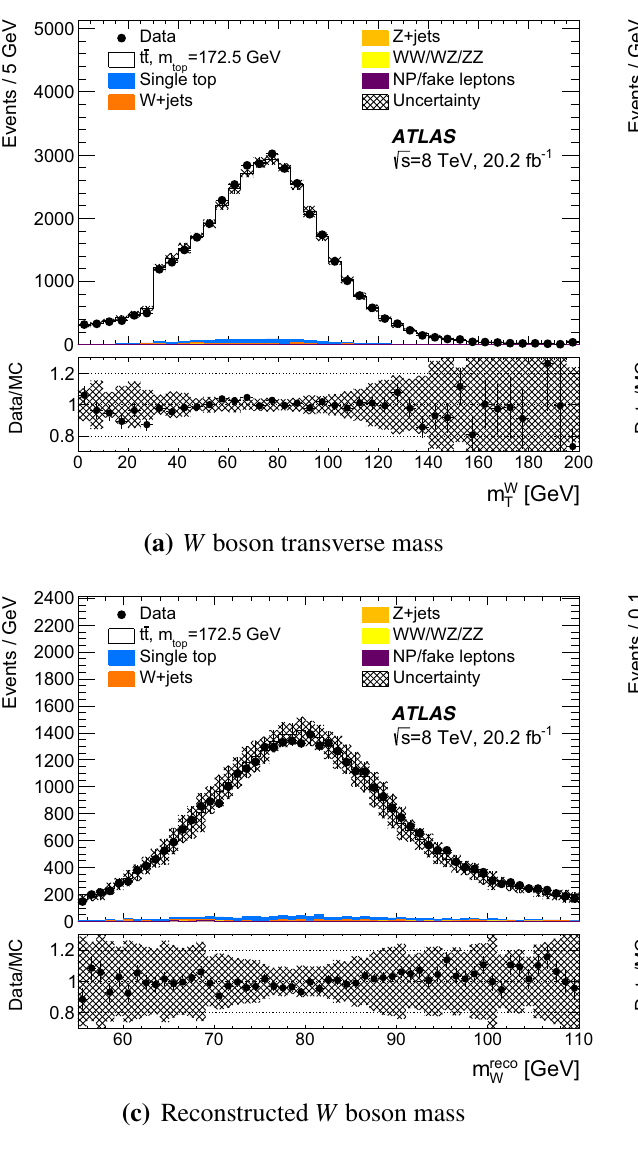
semi-leptonic top quark decay. The remaining figures show the three observables used for the determination of m top , where b shows the reconstructed top quark mass m reco top , c shows the reconstructed invariant mass of the W boson m reco and d shows the reconstructed ratio of jet W transverse momenta R reco . The three distributions are shown within the bq ranges of the template